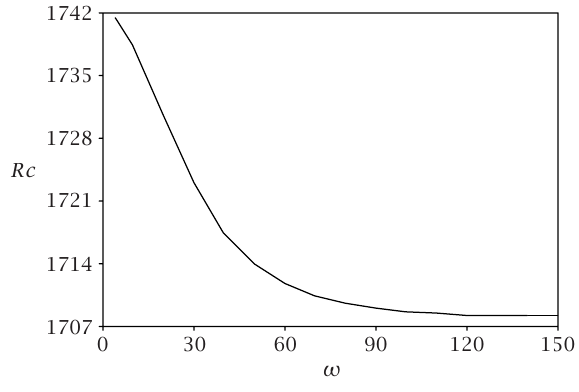
Figure 4.2 . Variation of Rc with ω : P = 0 . 73, ε = 0 . 1, and a = 3 .